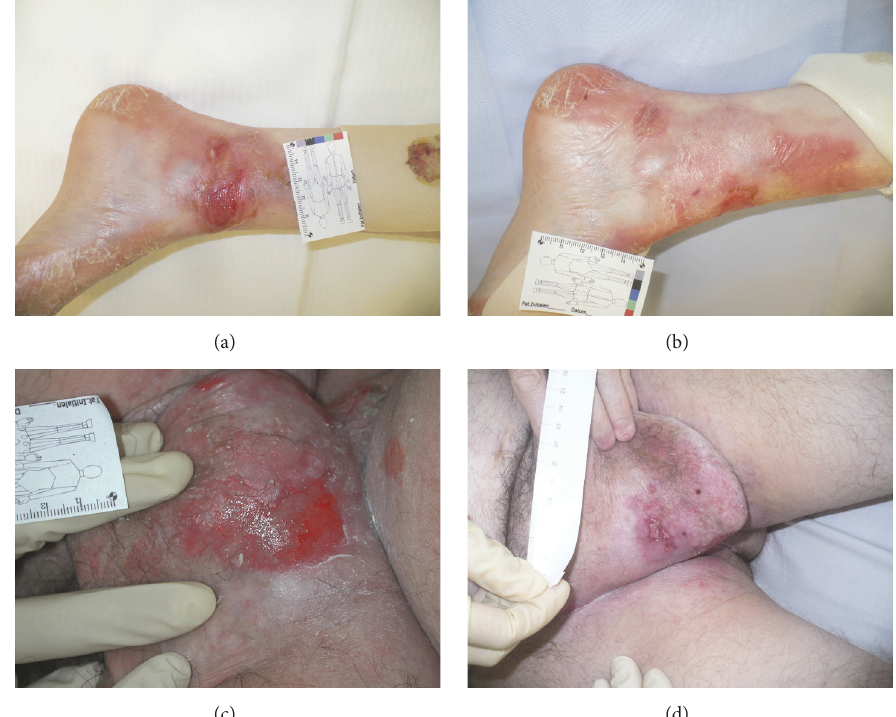
Figure 1: Healing of chronic wound on the ankle of a 12-year-old suffering from RDEB after 5 weeks of treatment with Oleogel-S10 (a-b). Healing of chronic wound in the groin of a 50-year-old male after only 6 days of treatment with Oleogel-S10